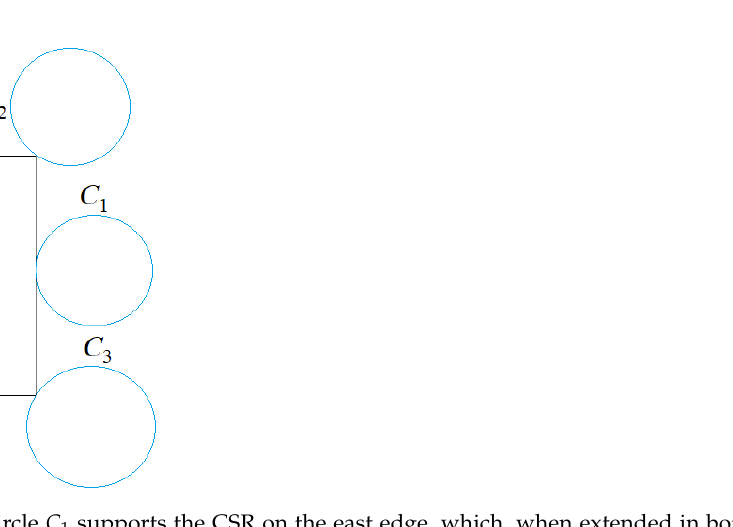
Figure 17. Case 3.1: Circle C 1 supports the CSR on the east edge, which, when extended in both directions, it eventually touches circles C 2 , C 3 .